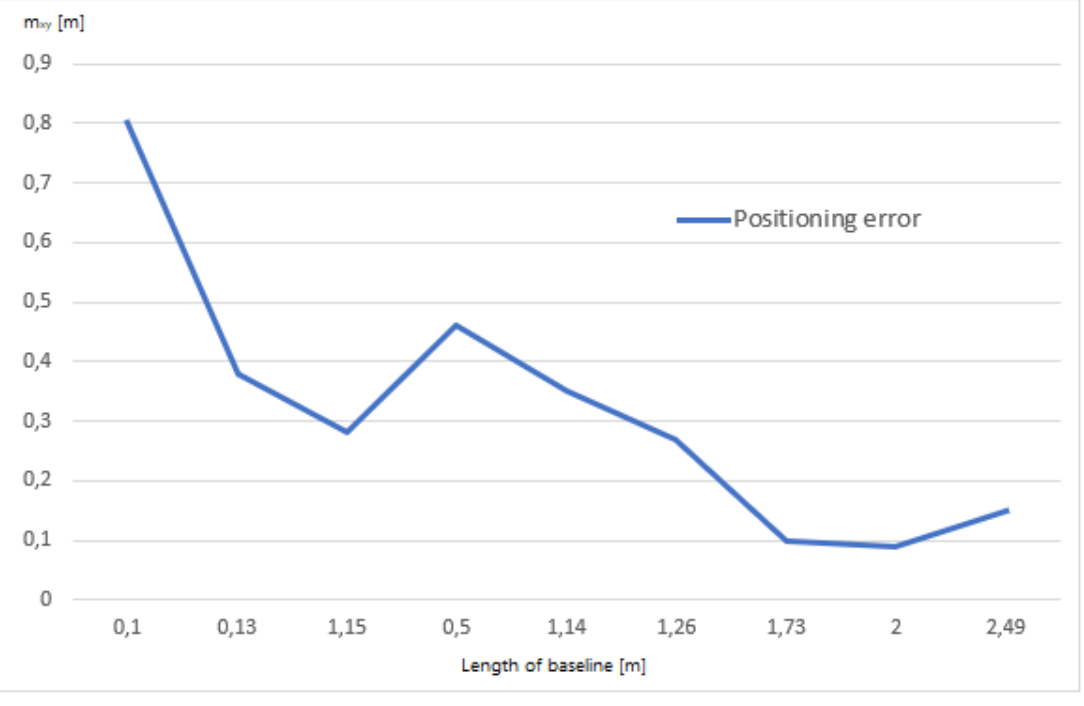
Figure 8. Values of mean coordinate Graph 1. Values of mean coordinate errors.